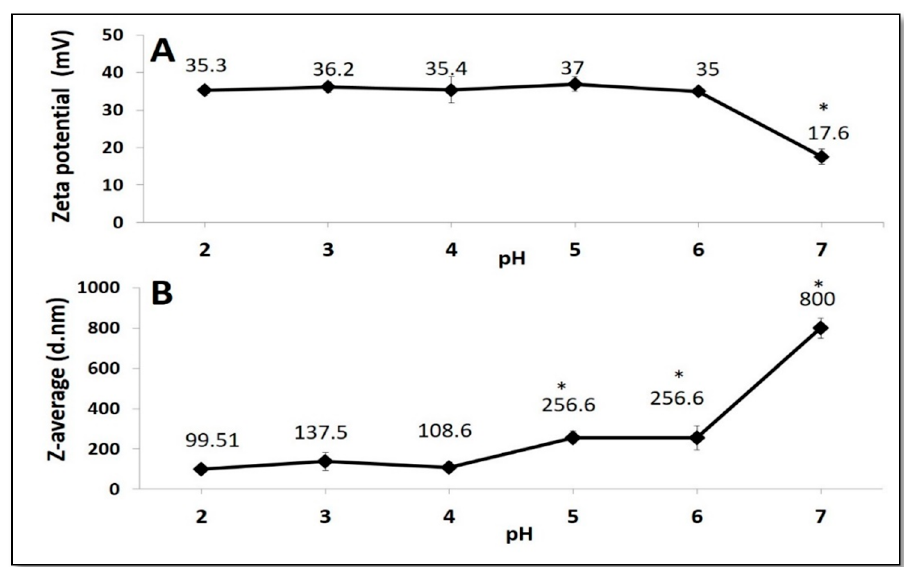
Figure 1. pH e ff ect on Zeta potential (Panel A ) and Z-average (Panel B ) of 1 mg / mL chitosan Figure 1. pH effect on Zeta potential (Panel A ) and Z-average (Panel B ) of 1 mg/mL chitosan nanoparticles (CH–NPs). Values marked with * were significantly di ff erent respect to the value at nanoparticles (CH–NPs). Values marked with * were significantly different respect to the value at pH pH 2.0. 2.0. Table 1. E ff ect of 1% mesoporous silica nanoparticles (MSN) or 1% chitosan nanoparticles (CH–NPs) on Zeta potential and Z-average on either grass pea flour (GPF)-based (without or with transglutaminase (TGase) (33 U / g protein)) or pectin (PEC)-based film forming solutions at pH 6.